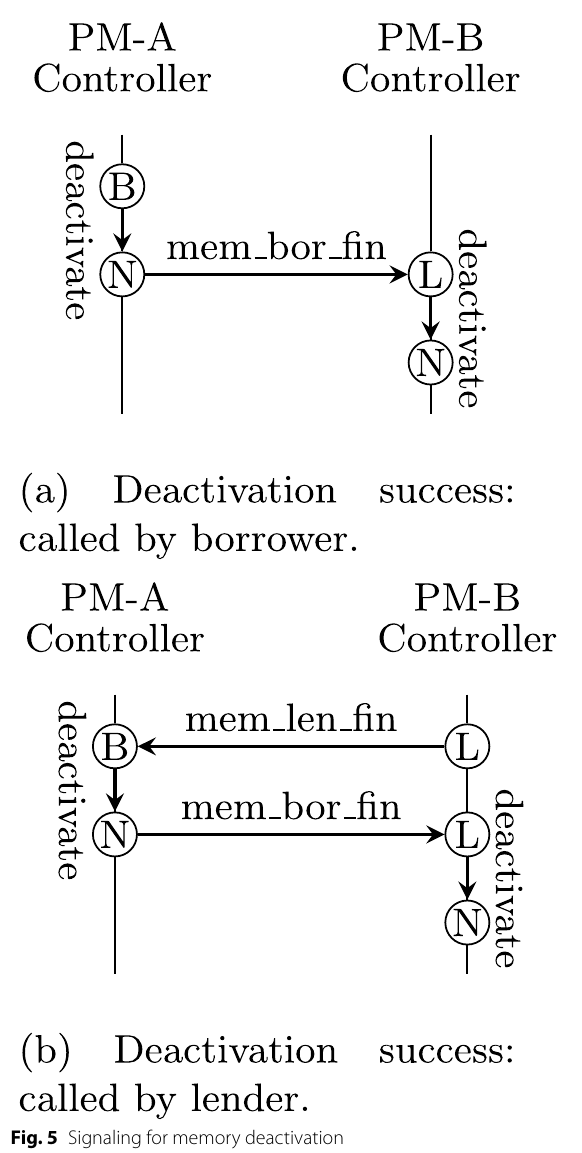
Fig. 5 Signaling for memory